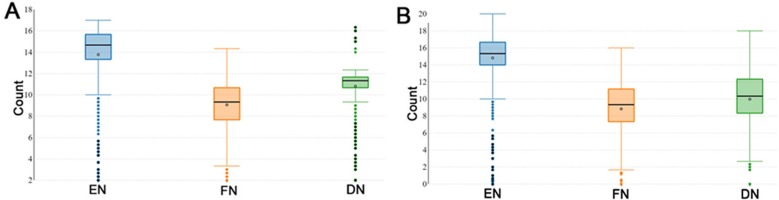
Boxplots showing duration of fertility trait.The boxplots show medians and interquartile ranges (IQRs) in (A) population 1 and (B) population 2. EN (number of eggs); FN (the number of fertile eggs after a single AI); and DN (the number of days post-insemination until last fertile egg).